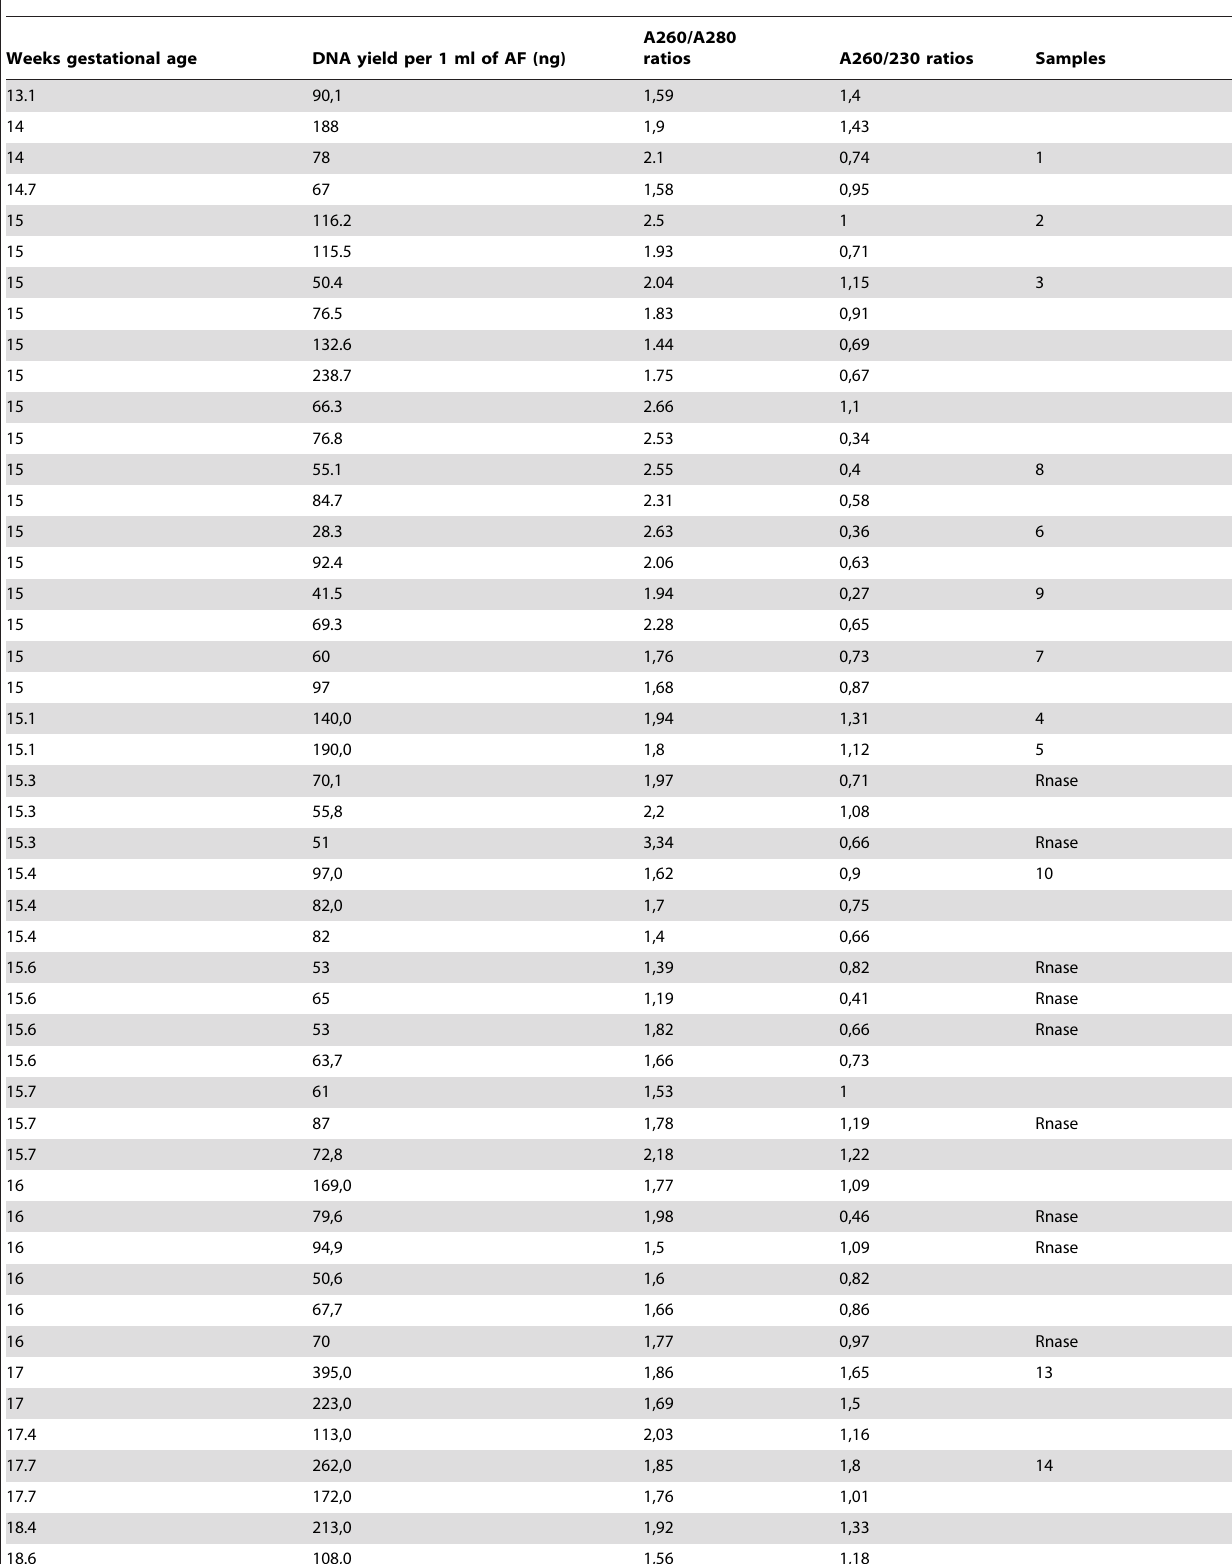
Table 3. Summary of DNA yield, purity (260/280 and 260/230 reading) extract by this optimized protocol of the 90 uncultured amniotic